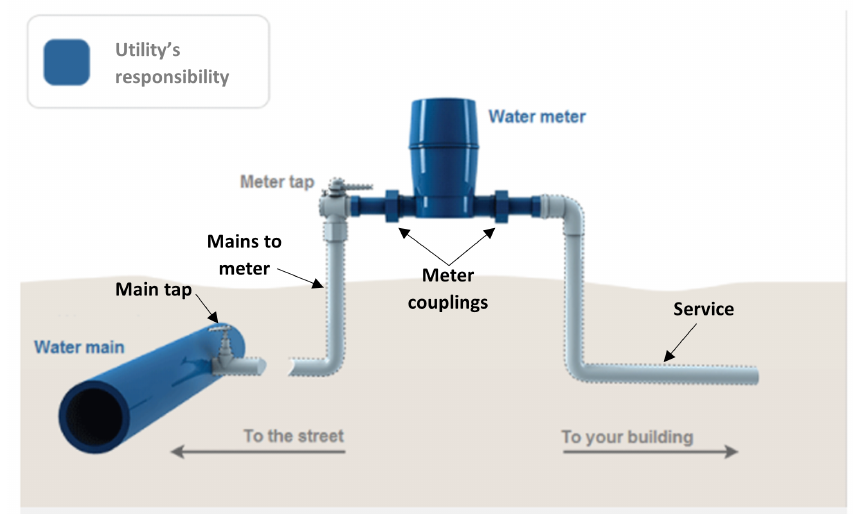
Figure 2. Utility’s mains to meter diagram.